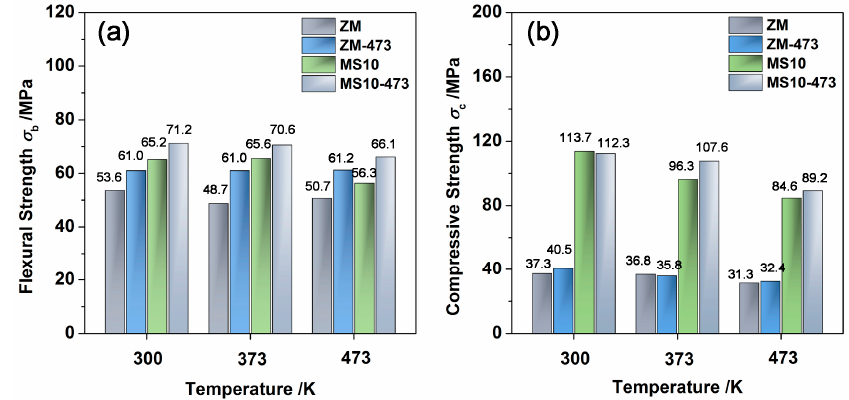
Figure 5. Unannealed and annealed ZM and MS10 samples as a function of testing temperature: ( a ) the bending strength and ( b ) the compressive strength.